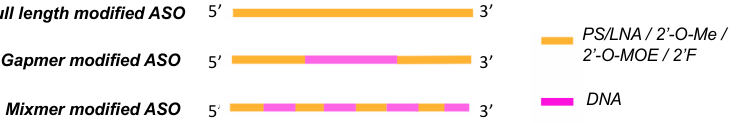
Figure 1. Antisense oligonucleotide (ASO) design. Chemically modified ASOs provide nuclease resistance and improved binding affinity to their target. Full length modified design represents chemical modifications throughout the sequence. Gapmer design includes a central region consist of DNA nucleotides and a stretch of LNA or 2 ′ modifications or PS nucleotides flanking both terminals of the sequence. Mixmer design contains LNA (or 2 ′ modifications) and DNA nucleotides present sequentially.